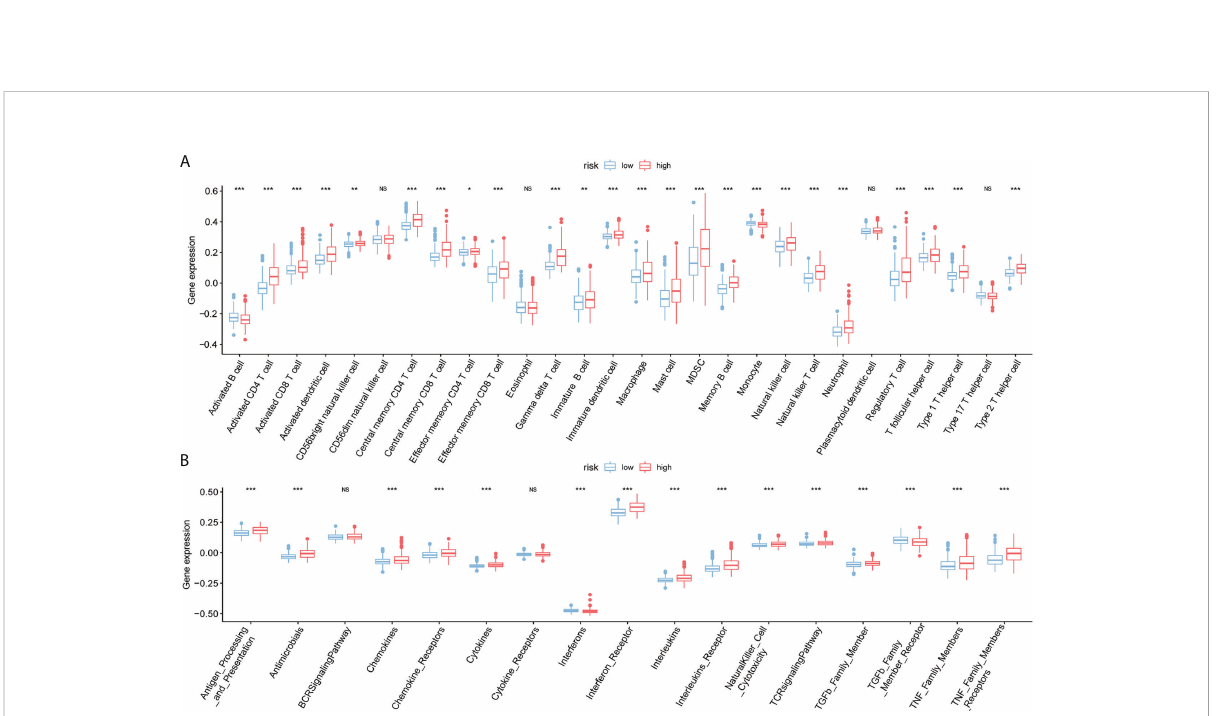
FIGURE 8 Immunoassay for ssGSEA. (A) The horizontal axis represents immune cells, the vertical axis represents immune cell in fi ltration abundance, red represents the high-risk group, and blue represents the low-risk group. (B) Box plot of high- and low-risk groups and immune function set scores, the horizontal axis represents the immune function set, and the vertical axis represents the immune function set score.(NS:no signi fi cant) (*P < 0.05, **P < 0.01, ***P <